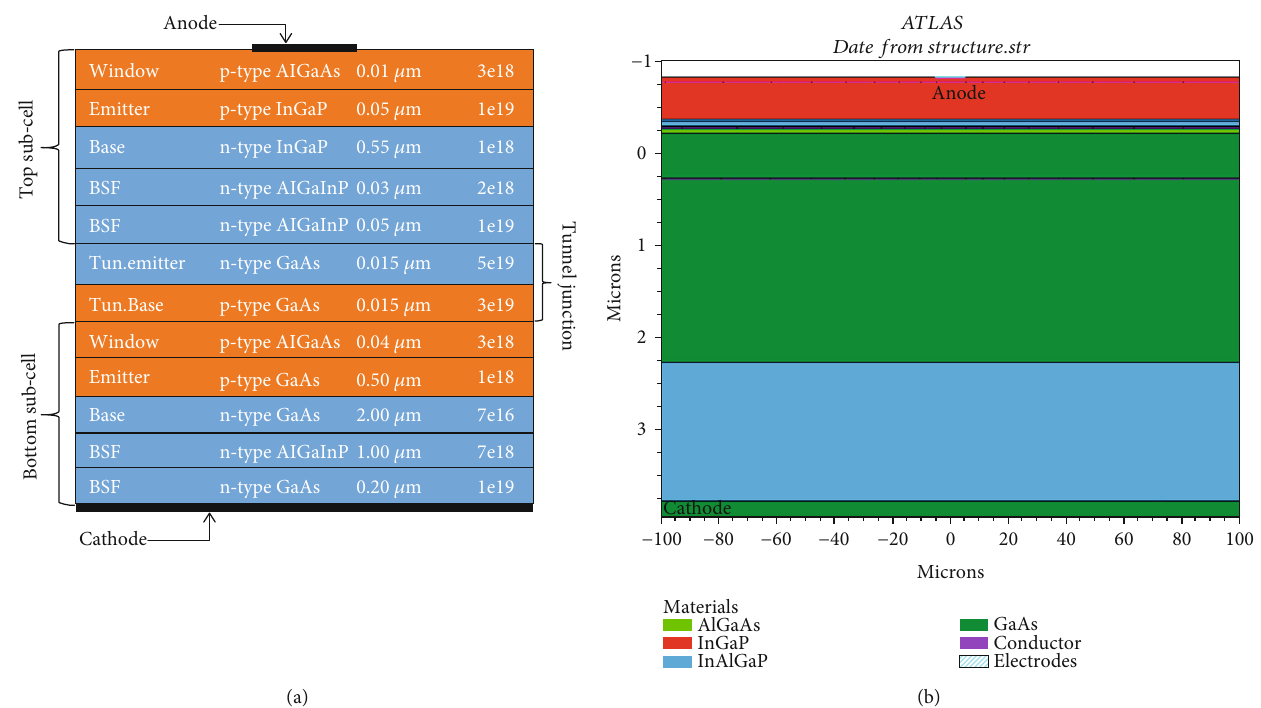
Figure 1: Schematic diagram of the InGaP/GaAs DJ solar cell structure. (a) Di ff erent layers showing the used materials with their thicknesses and doping levels. (b) Presented solar cell structure output from the SILVACO TCAD